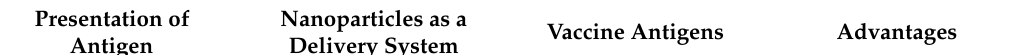
Table 1. Merits and demerits of nanoparticle-based COVID-19